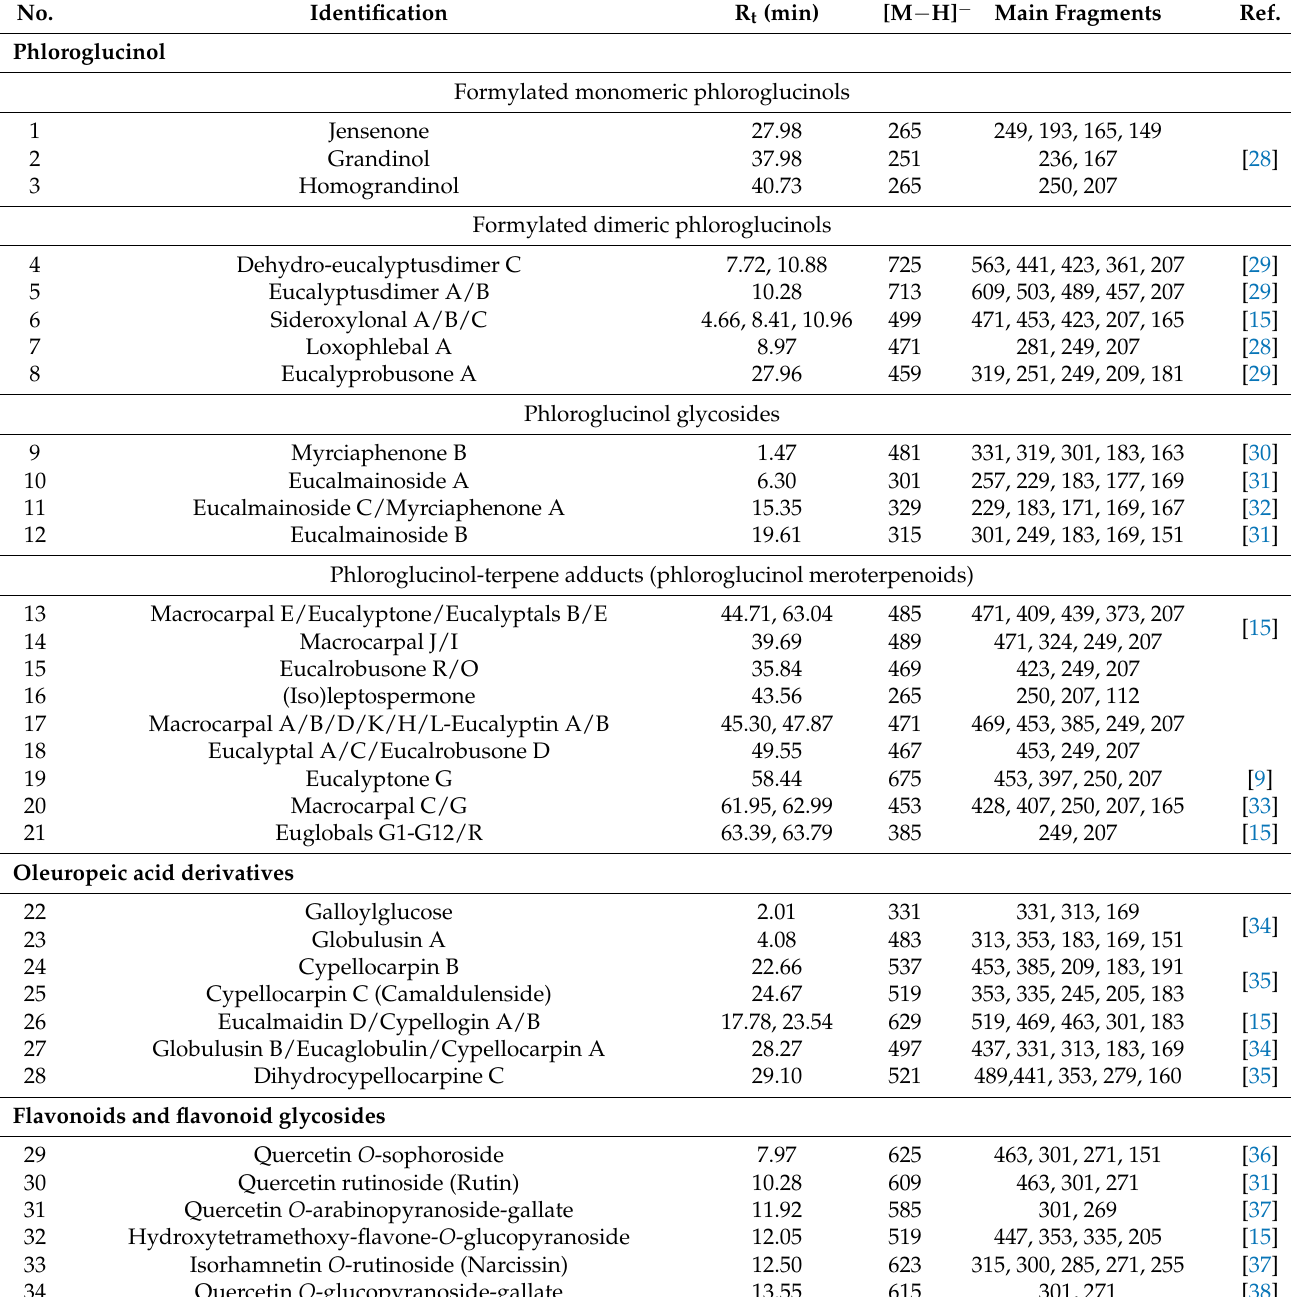
Table 3. Secondary metabolites identified in the methanolic extract of E. sideroxylon flowers.